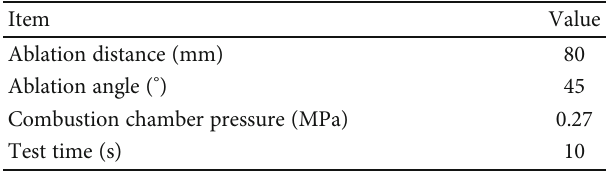
Figure 3: SEM photograph of the alumina powder. Table 2: Parameters of the experiment system.